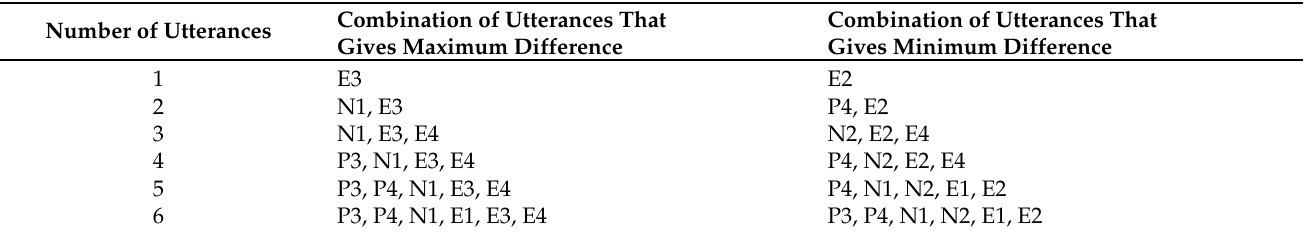
Table 4. Combinations of utterances that gave the maximum/minimum difference for each number of utterances (up to six utterances).